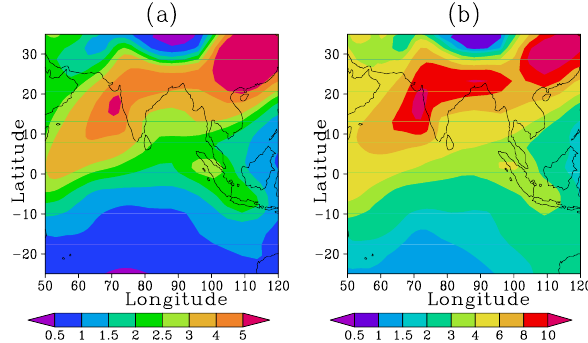
Fig. 10. Average sulphate distribution for January to March 1999 over the INDOEX domain: (a) surface concentration (µgSO 2 − m − 3 ) ; (b) sulphate column burden (mgSO 2 − 4